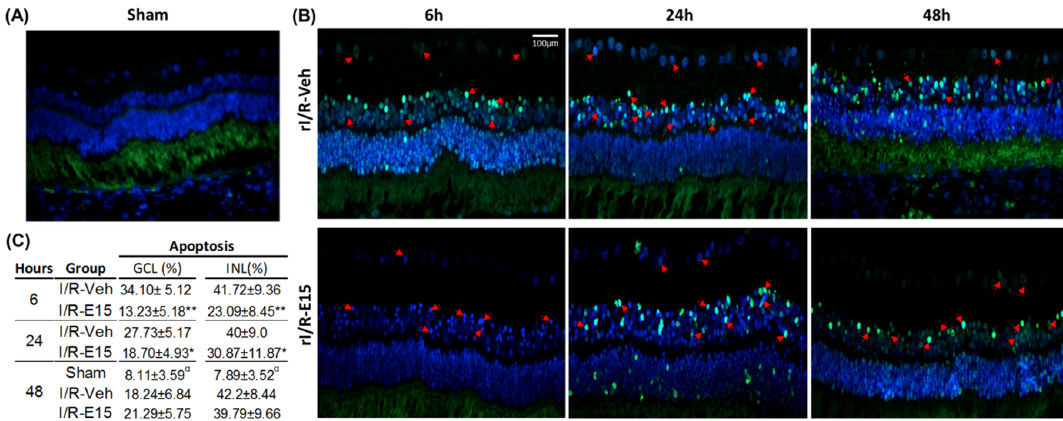
Figure 3. Neuroprotective effect of EGCG at 15 mg/kg (E15) in a timeline. Apoptosis was determined by terminal deoxynucleotidyl transferase dUTP nick end labeling (TUNEL) assay. ( A ) Sham group at 48 h after rI/R; ( B ) vehicle-treated groups at the 6, 24, and 48 h after rI/R (rI/R-veh; upper panel) and E15-treated group at the same times (rI/R-E15; bottom panel). Some apoptotic cells are highlighted with red arrows and their nuclei stained with DAPI (blue). In ( C ), the mean ± SD percentage of positive cells in the INL and GCL are shown. * p < 0.05 and ** p < 0.01 compared to rI/R-veh, and α p < 0.01 compared to rI/R-veh and rI/R-E15 groups, at 48 h. Scale bar = 100 μm.